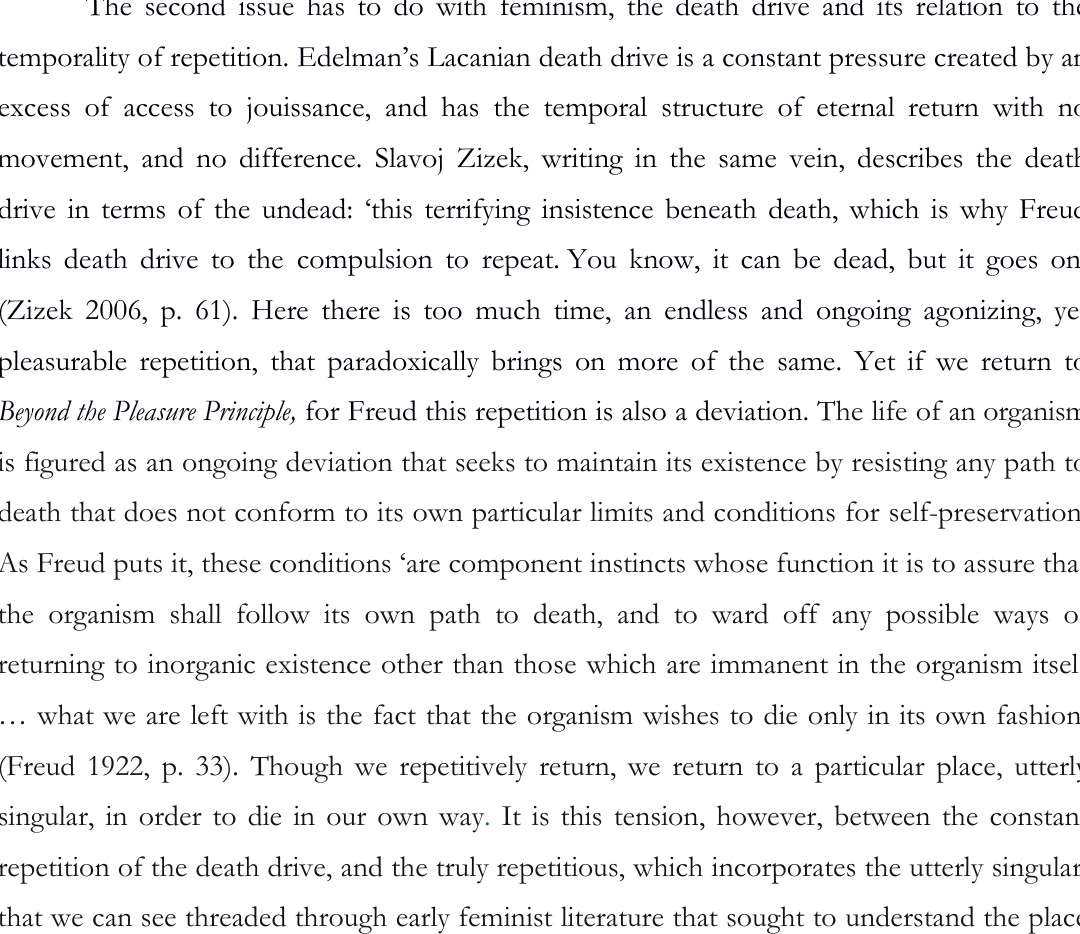
Lisa Baraitser, Time and Again: Repetition, Maternity and the Non-Reproductive Studies in the Maternal , 6(1), 2014,